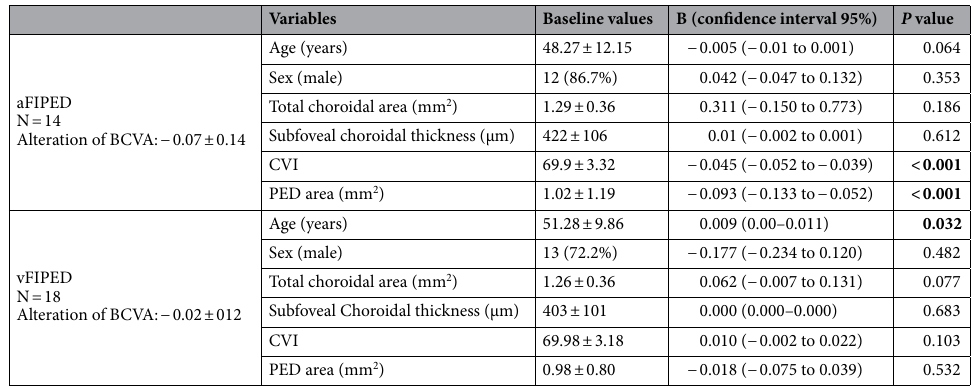
Table 4. Association of baseline characteristics with alteration of vision following treatment in eyes with aFIPED and vFIPED.